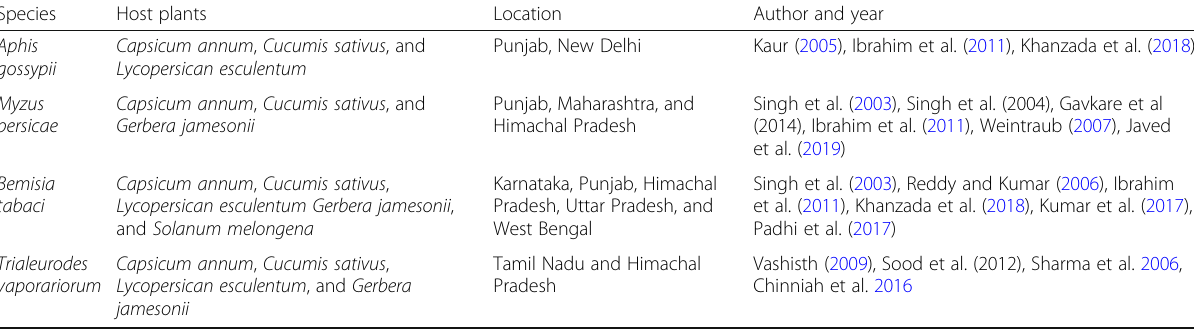
Table 1 List of aphid and whitefly species recorded under protected conditions in different regions of India